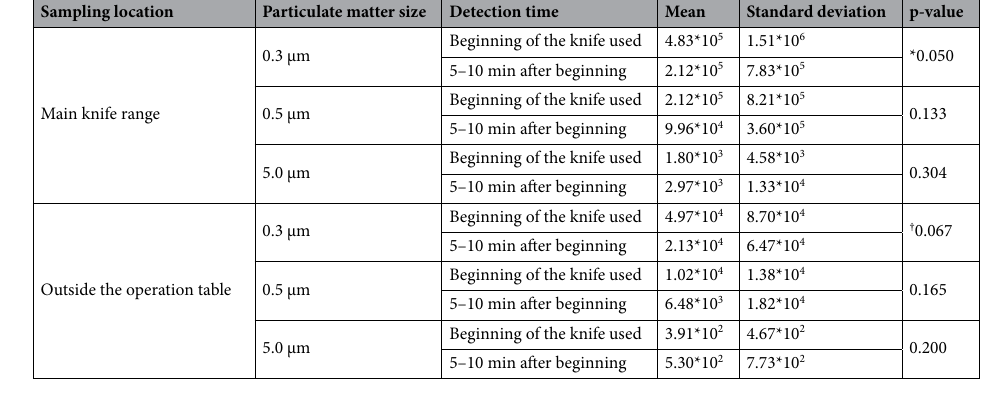
Table 2. The analysis of the concentration number of particulate matter detected during the use of electrocautery knife at different time points. Unit: particles/ft 3 . † 0.05 < p < 0.1,*p < 0.05.